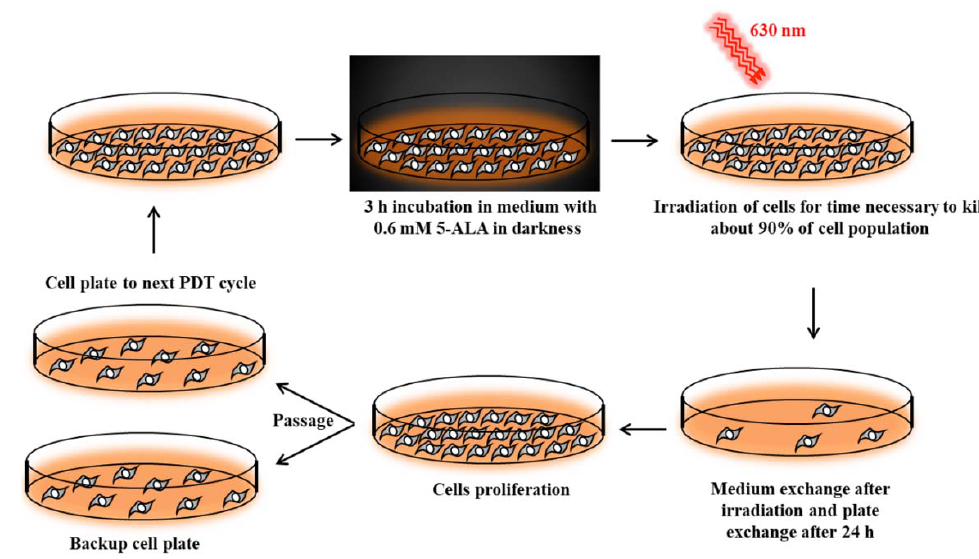
Figure 10. Isolation of PDT ‐ resistant